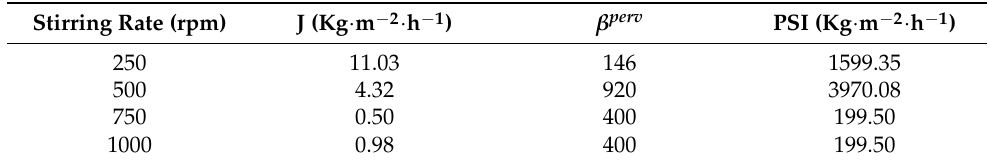
Table 10. Pervaporative parameters of a SILICONE1200 membrane obtained during 1.5 h of separa- tion at 20 ◦ C at different stirring rates and a membrane thickness of 260 µ m.